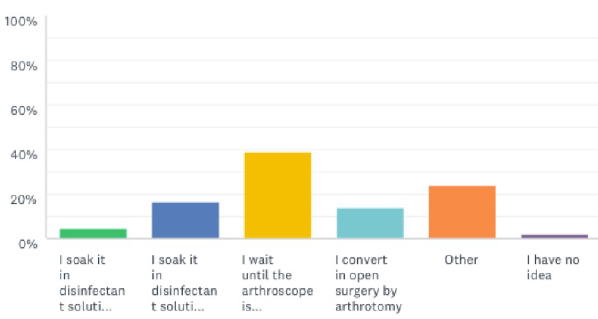
Figure 3. In the event of a sterility mistake during a sports medicine procedure.